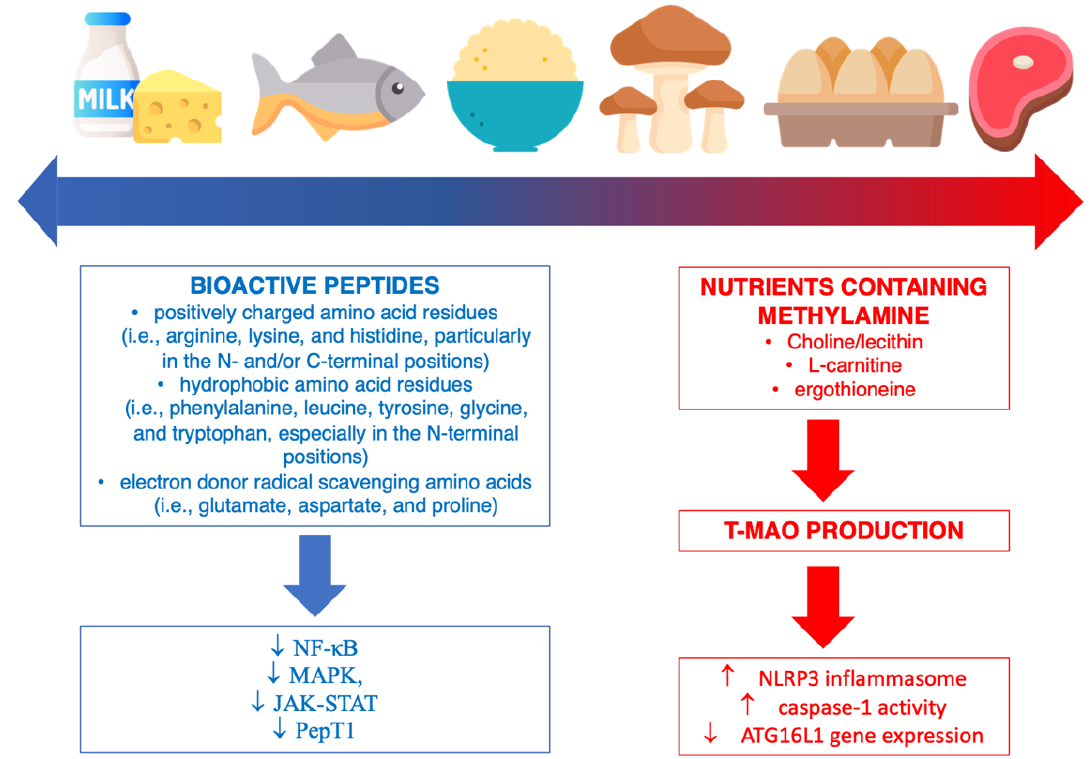
Figure 4. Mechanisms of action related to the inflammatory pathways of protein-rich foods. Arrows denote increment/increase or decrement/decrease.